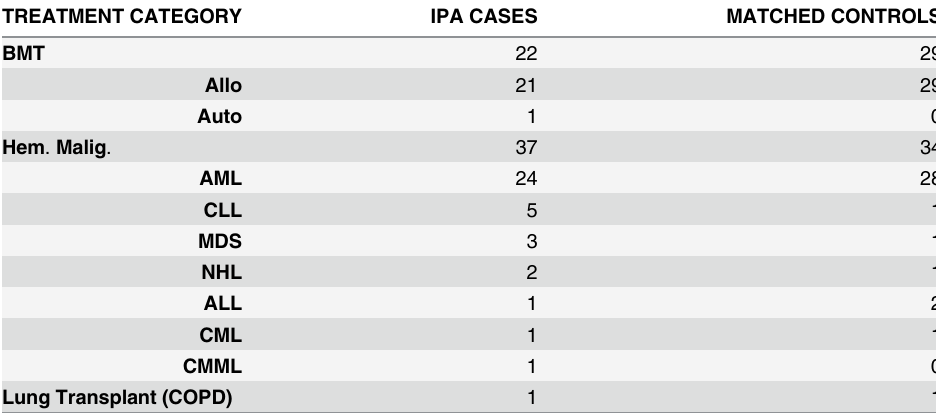
Table 2. Treatment regimens for case and controls, by